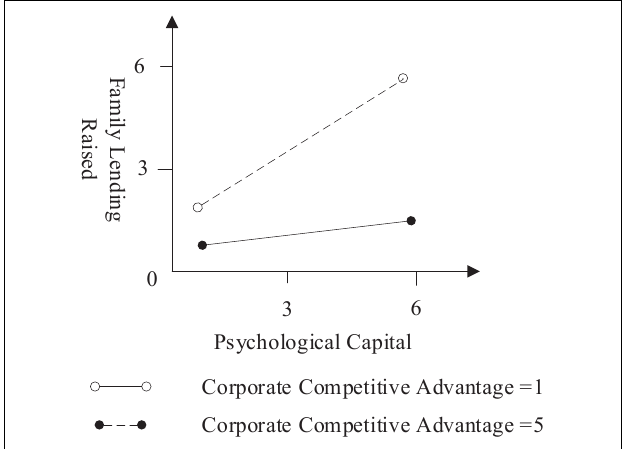
FIGURE 2 | The moderator of corporate competitive advantage.